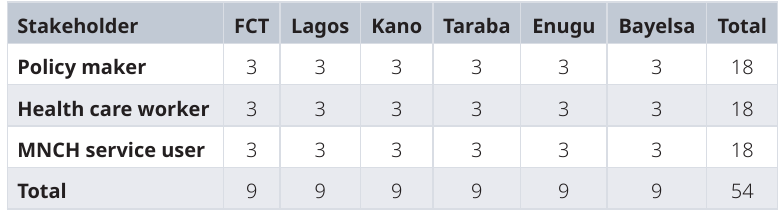
Table 2. Stakeholders to be